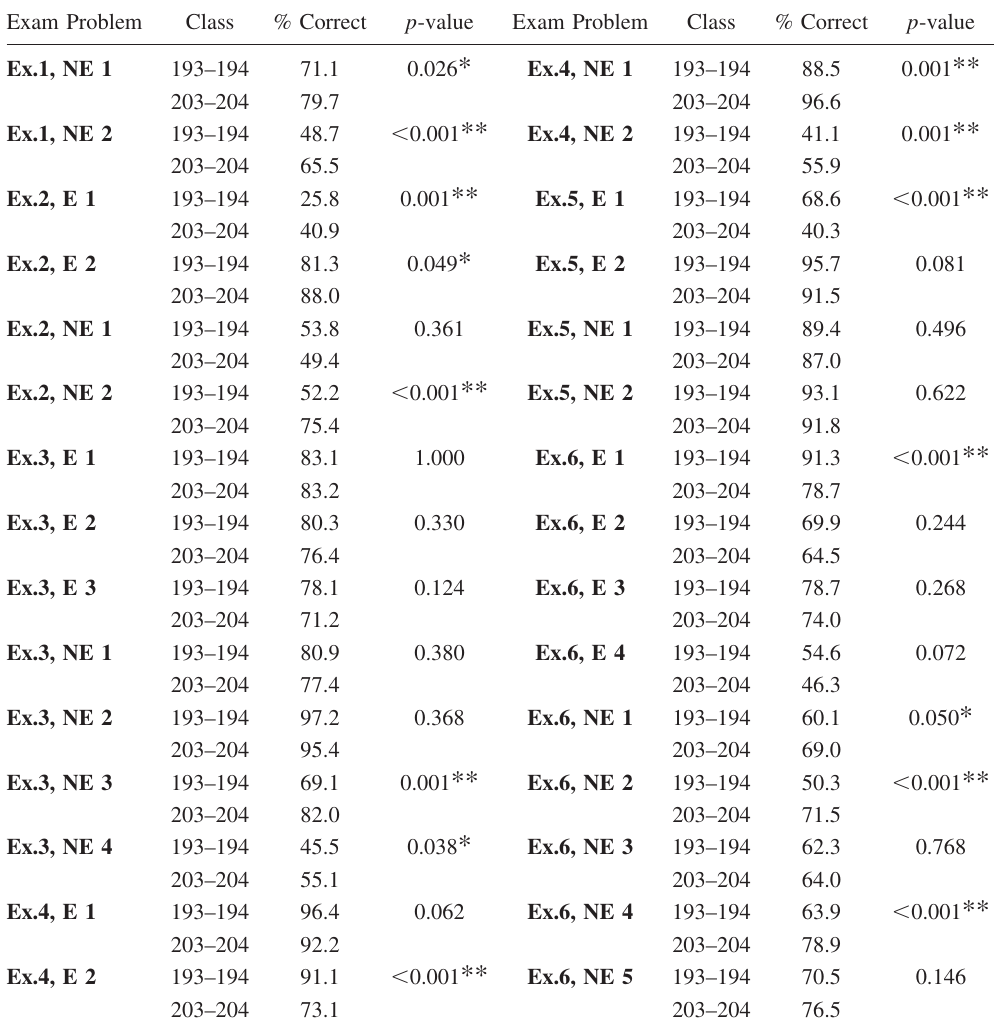
TABLE III. Cross tabulation of performance on multiple choice (cid:1) MC (cid:2) exam problems, and the exact significance (cid:1) 2-tailed (cid:2) for chi-squared tests of independence between each class. (cid:1) =significant at 0.05 level, (cid:1)(cid:1) =significant at 0.01